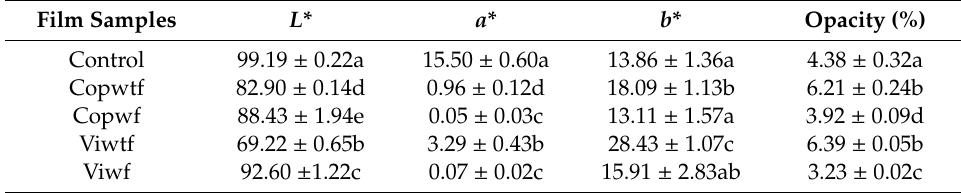
Table 1. Optical properties and opacity of Copena F1 without fibre (Copwtf), Copena F1 with fibre (Copwf), Villanueva without fibre (Viwtf) and Villanueva with fibre (Viwf)